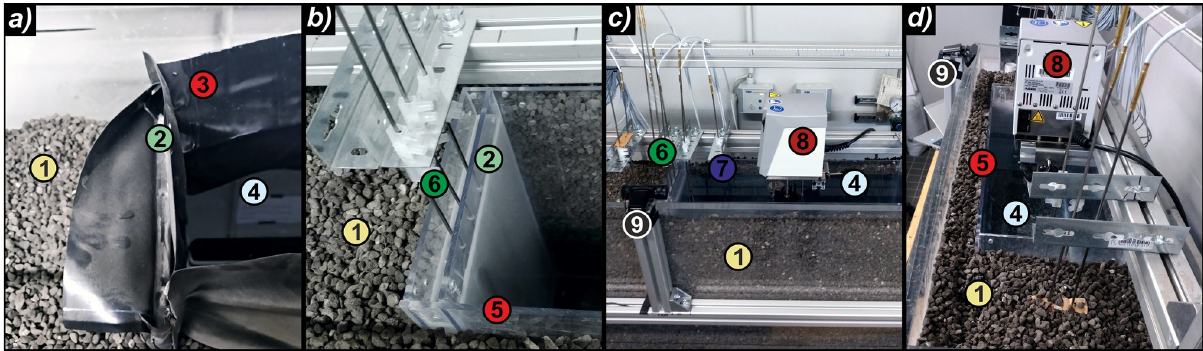
Fig 2. Experimental variants with (a) black PVC foil and (b-d) PS as sealing layer. 1: surrounding material, 2: paraffin wax insulation layer, 3: PVC sealing foil, 4: filling/water, 5: PS sealing plates, 6, 7: temperature sensors in paraffin wax/filling, 8: heating device, 9: camera.